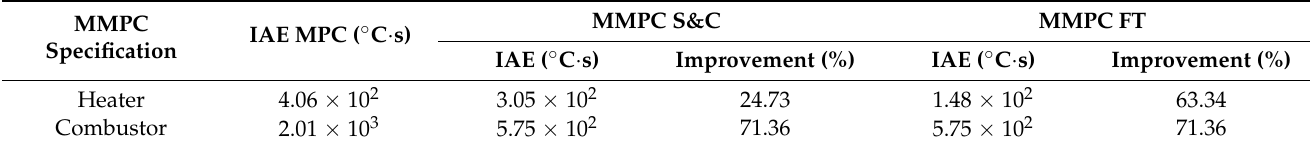
Table 18. MMPC performance (IAE) and performance improvement in the steam reformer unit.